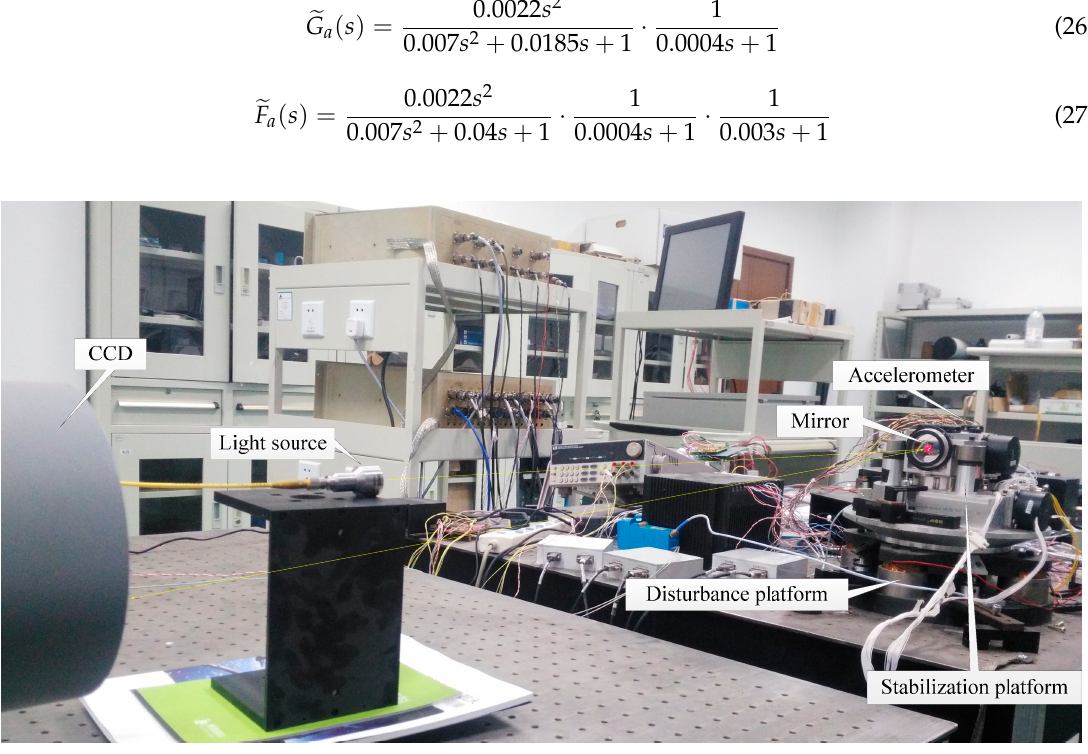
Figure 6. Experimental apparatus.